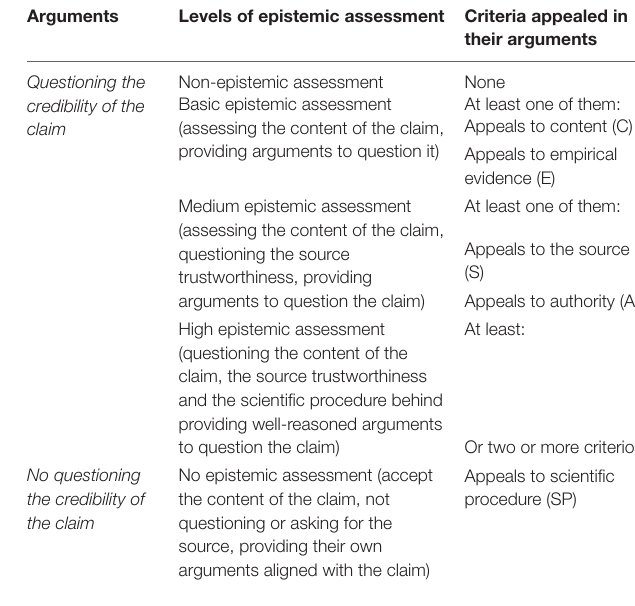
TABLE 2 | Code scheme for research questions 1 and